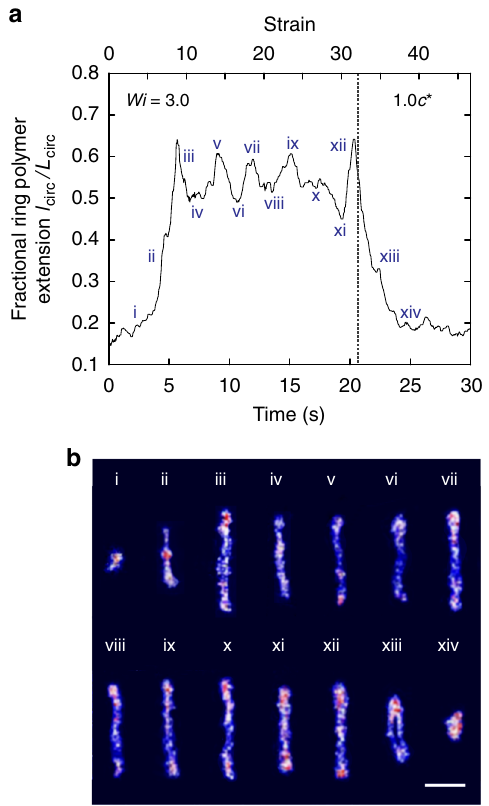
Fig. 4 Characteristic transient stretching trajectory and single molecule snapshots. Experimental data shows large magnitude extension fl uctuations for ring polymers in extensional fl ow. a Representative single molecule trajectory for a ring polymer in 1.0 c * semidilute unentangled linear polymer solution at Wi = 3.0. The characteristic timescale between each peak is 2.8 s corresponding to 4.4 strain units. Source data are provided as a Source Data fi le. b Single molecule snapshots of the ring polymer corresponding to the trajectory in a , where the Roman numerals correspond to individual time points along the trajectory. Scale bar = 2.5 μ